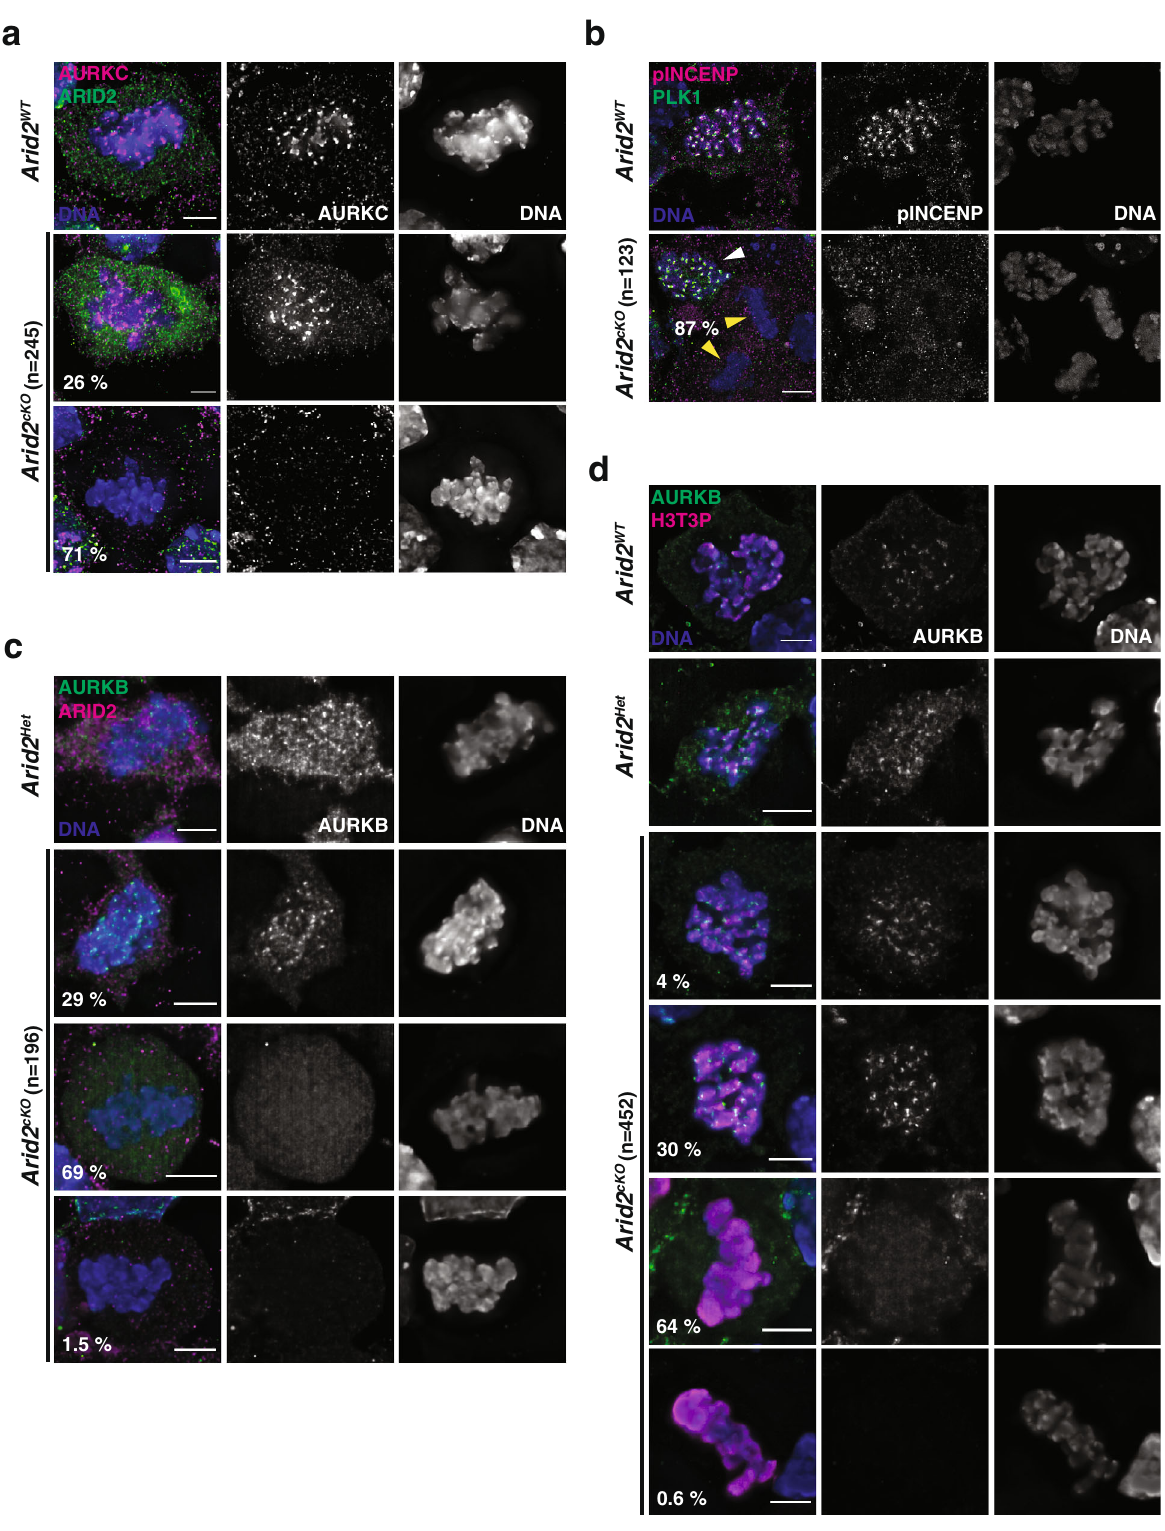
Fig. 6 ARID2 in fl uences chromosome passenger complex recruitment. a , b Arid2 WT and Arid2 cKO metaphase-I spermatocyte squashes immunolabelled for a AURKC (magenta) and ARID2 (green), b pINCENP (magenta) and PLK1 (green). Internal controls (white arrowhead) and mutants (yellow arrowhead) are indicated. c , d Control and Arid2 cKO metaphase-I spermatocyte squashes immunolabelled for AURKB (green) and c ARID2 (magenta), d H3T3P (magenta). a – d DNA stained with DAPI (blue), number of metaphase-I spermatocytes scored ( n ), and their proportions (%) in Arid2 cKO squashes are indicated. Scale bar: 5 μ m, magni fi cation: